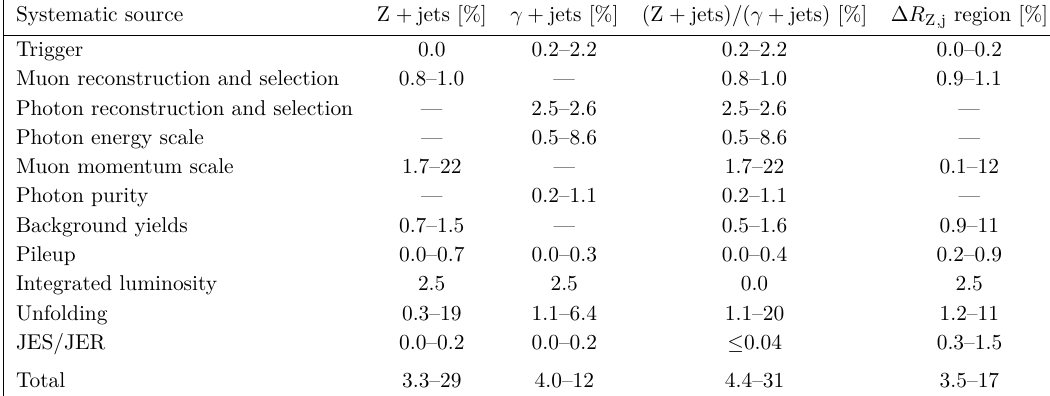
Table 1 . The contributions to the uncertainty in the differential cross section measurements for the Z + jets and γ + jets processes, the Z /γ ratio, and the ∆ R expressed in percent, and a range represents the minimum and maximum effect